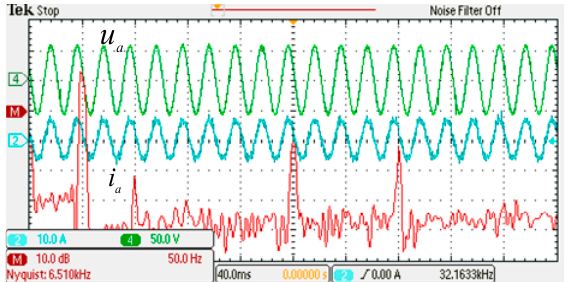
Figure 15. The experimental waveforms of the grid current and the corresponding FFT analysis for the 3 μ s overlap time at 40 kHz switching frequency.